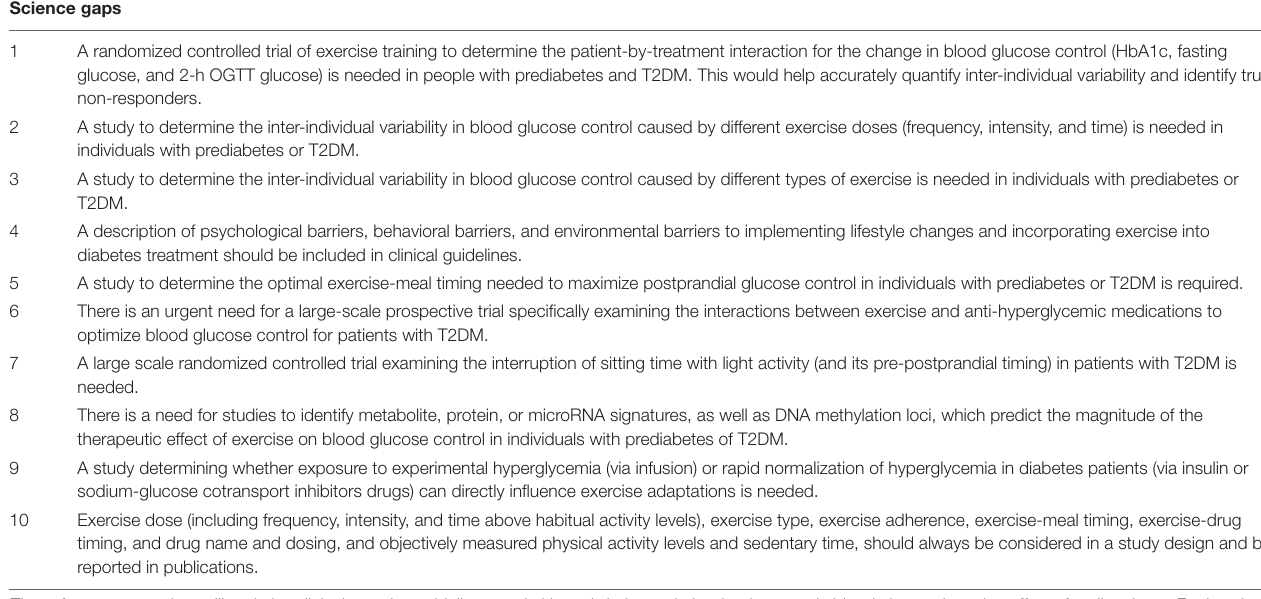
TABLE 3 | Science gaps which, if filled, will increase our understanding of inter-individual variability in the therapeutic blood glucose lowering effect of exercise for individuals with prediabetes and/or type 2 diabetes. Science